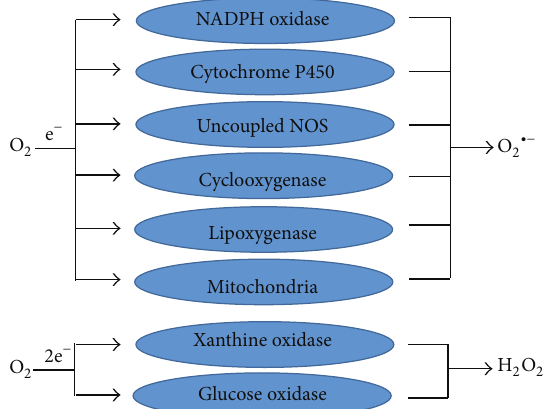
Figure 2: Sources of O 2∙− and H 2 O 2 in cells. The figure shows the enzymatic pathway of superoxide anion (O 2∙− ) and hydrogen peroxide (H 2 O 2 ) generation in